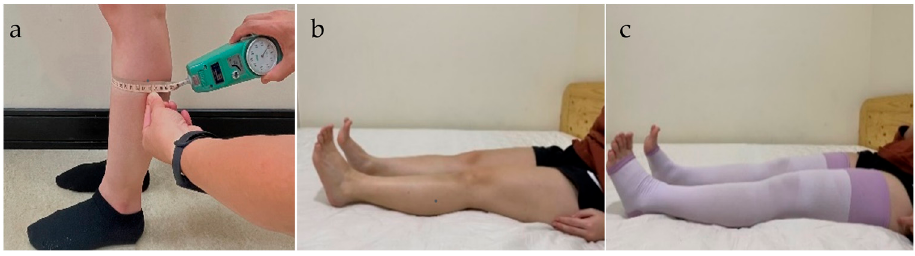
Figure 1. Schematic of measurement for shank circumference ( a ), and participants not wearing ( b ) and wearing compression stockings ( c ).